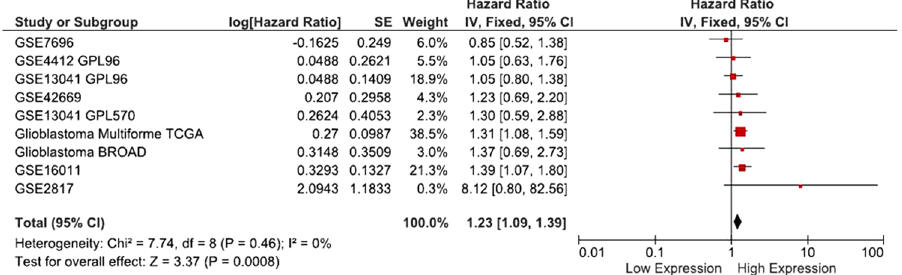
Figure 3. Meta-analysis of 9 glioblastoma SurvExpress datasets, showing that a DDIT4 expression over the median increases the risk of death by 23%.